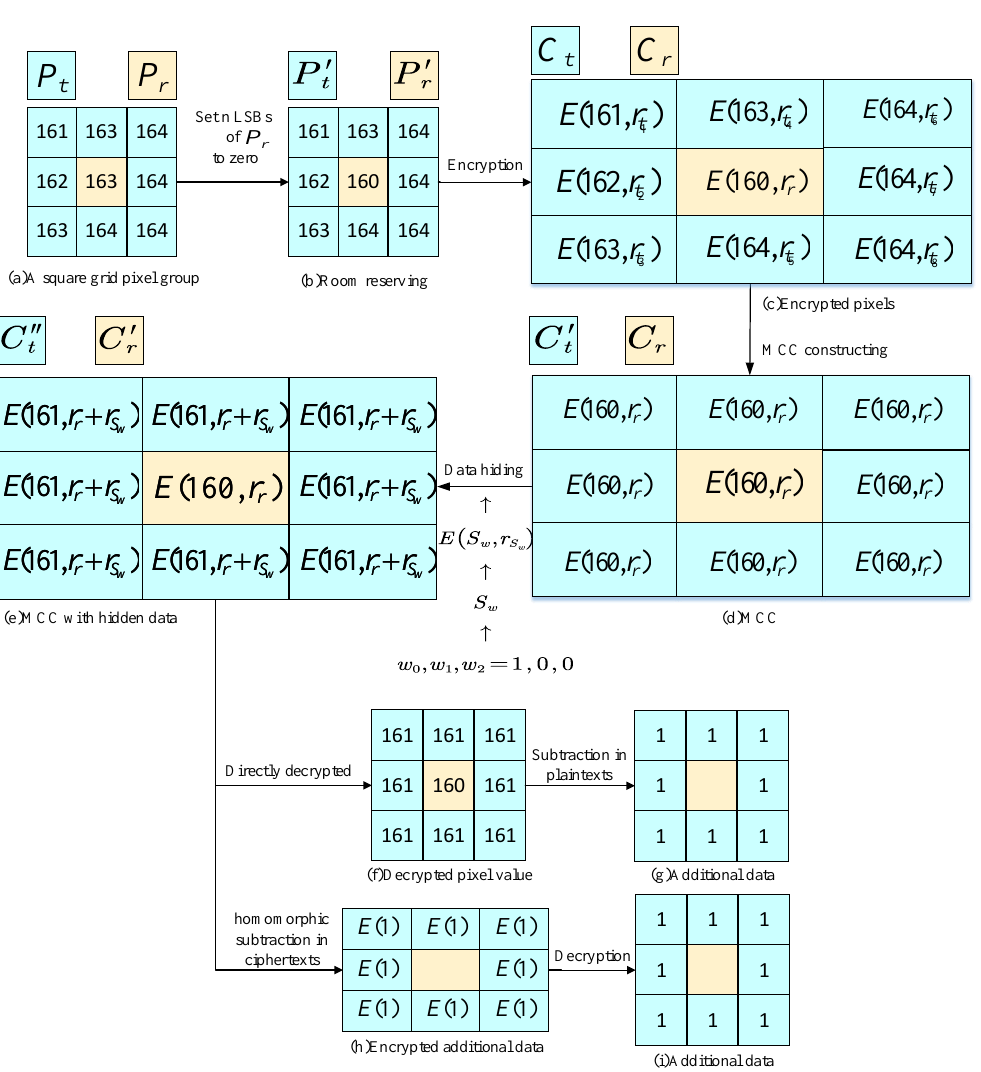
Figure 5. n = 3 is used as an example to illustrate the program